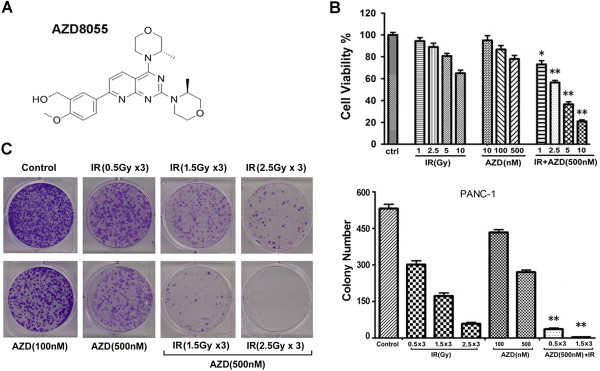
AZD8055 blocks radiation-induced mTOR phosphorylation and sensitizes pancreatic cancer cells to radiotherapy. (A) Chemical structure of mTOR dual inhibitor AZD8055, [5-[2,4-Bis((3S)- 3-methylmorpholin −4-yl)pyrido[2,3-d]pyrimidin-7-yl]-2-methoxyphenyl]methanol. (B) PANC-1 cells were treated with indicated doses of radiation in the absence or presence of AZD8055 for 48 h, Cell growth inhibition was analyzed by SRB assay. Error bars represent as mean ± SD. *, P < 0.05 vs. control or IR treatment alone and **, P < 0.01 vs. control or IR treatment alone. (C) PANC-1 cells were treated with radiation or AZD8055, alone or in combination, and cell viability was analyzed by colony formation assay. The experiment was repeated three times and the number of colonies was presented as mean ± SD. **, P < 0.01 vs. IR or AZD8055 treatment alone.